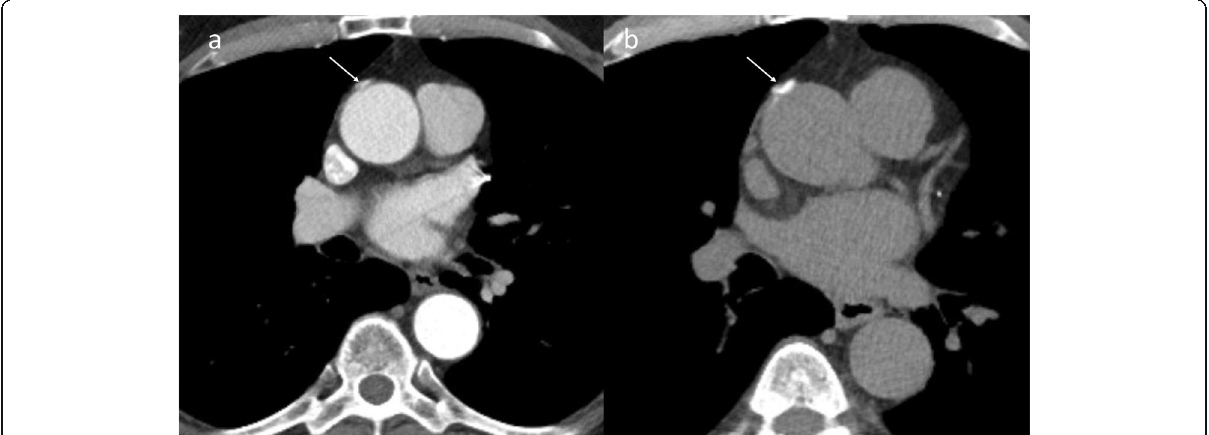
Fig. 16 A 89-year-old female patient with acute chest pain. Contrast enhanced axial CT ( a ) image was suspicious of a small pseudoaneurysm (arrow); however, non-contrast CT ( b ) image identified the outpouching as surgical pledget